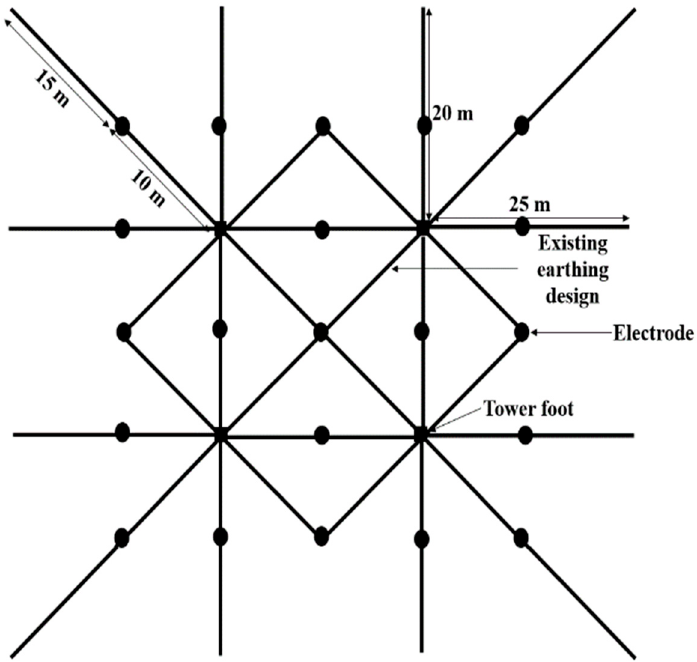
Figure 7. New earthing design: Diamond ‘Crowfoot’.